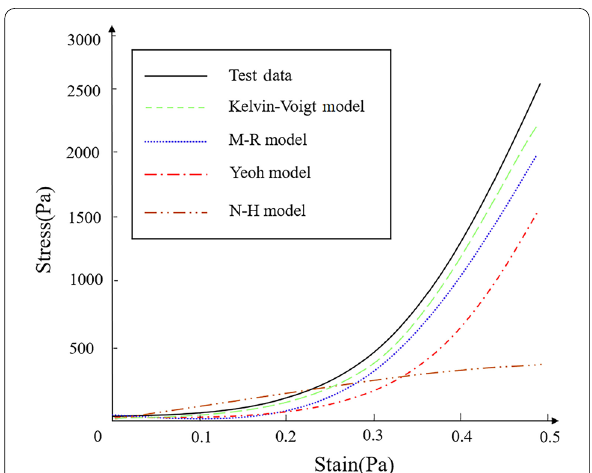
Figure 4 Strain-stress curve obtained by experiment